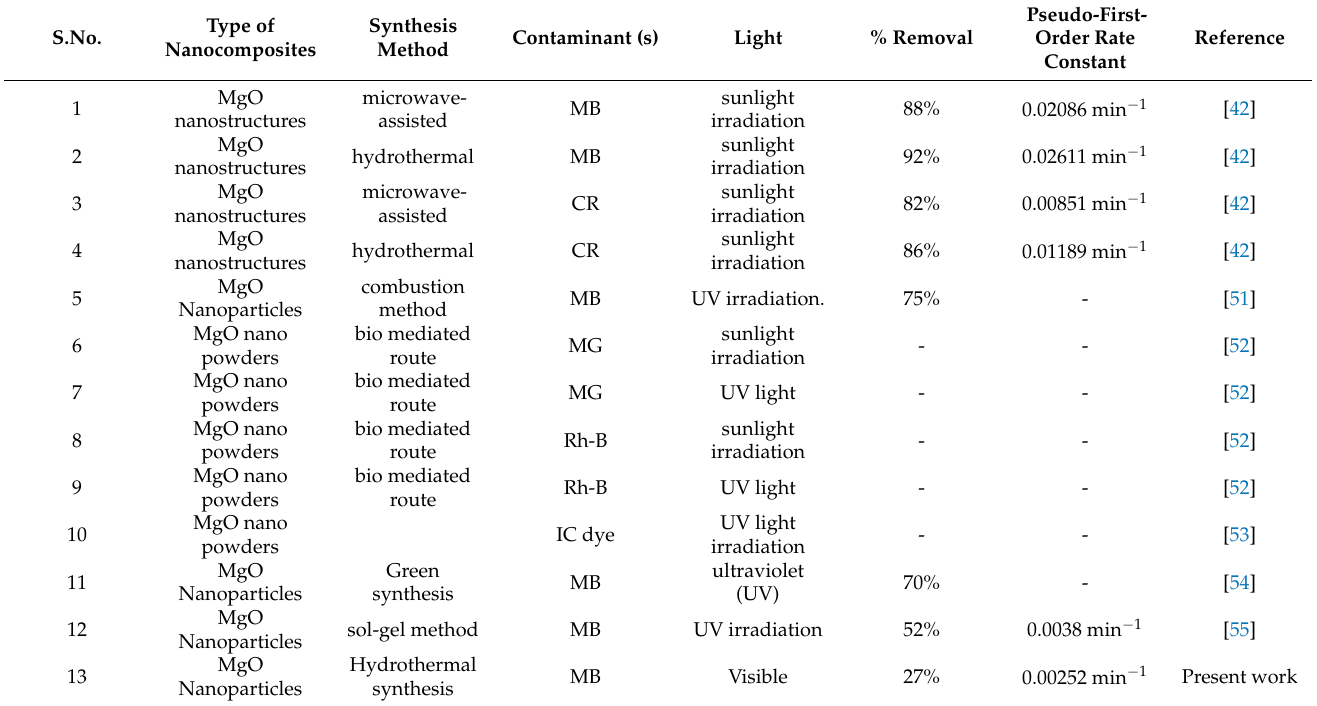
Table 2. Comparison of the photocatalytic degradation of dyes using various MgO